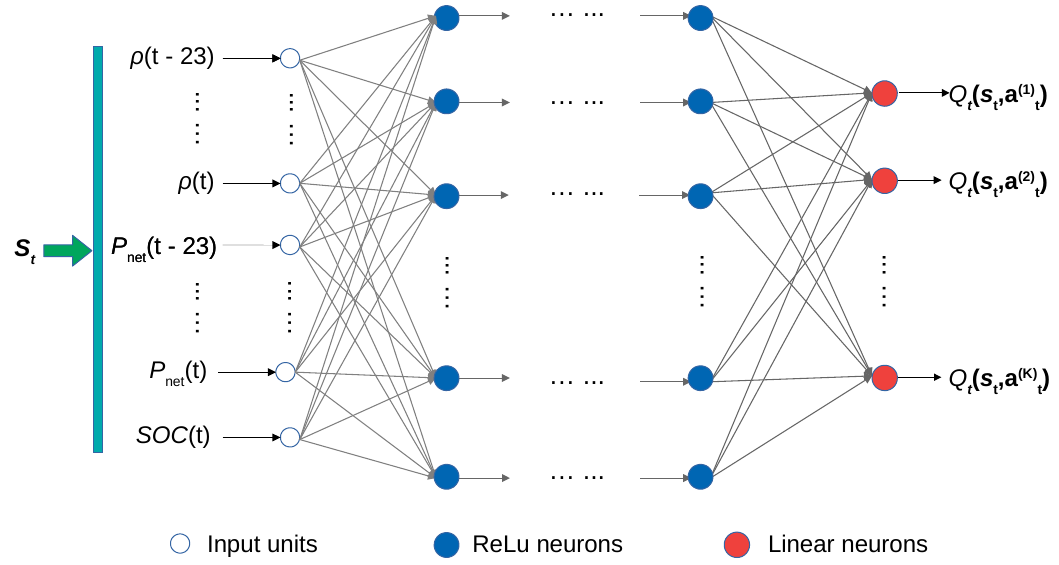
Figure 1. Architecture of the designed Q-network. The inputs of the Q-network are the MG state s t at time step t , and the outputs are the approximate action-values (cid:101) Q ( s , a ( k ) | (cid:126) θ ) with respect to the corresponding action a ( k ) . The hidden layers are fully connected multi-layer perceptrons with nonlinear activation function using